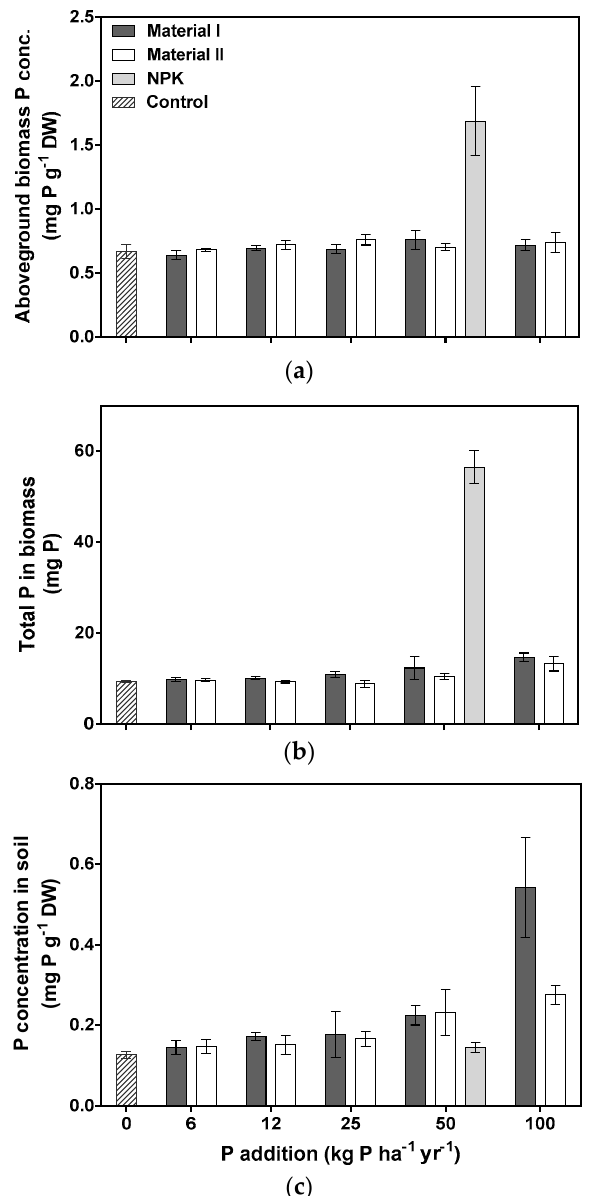
Figure 3. Effects of increasing phosphorus (P) supply when added as P-enriched material (I or II) with five P levels (6, 12, 25, 50, 100 kg P ha − 1 yr − 1 ) on ( a ) P concentration in aboveground Zea mays biomass (mg P g − 1 DW), ( b ) total P content in Zea mays biomass (mg P), and ( c ) P concentration in the soil after harvest of belowground biomass (mg P g − 1 DW). The control treatment had no P supplied, and the NPK fertilizer treatment had a P supply corresponding to 50 kg P ha − 1 yr − 1 . Values are averages ± SEM ( n =